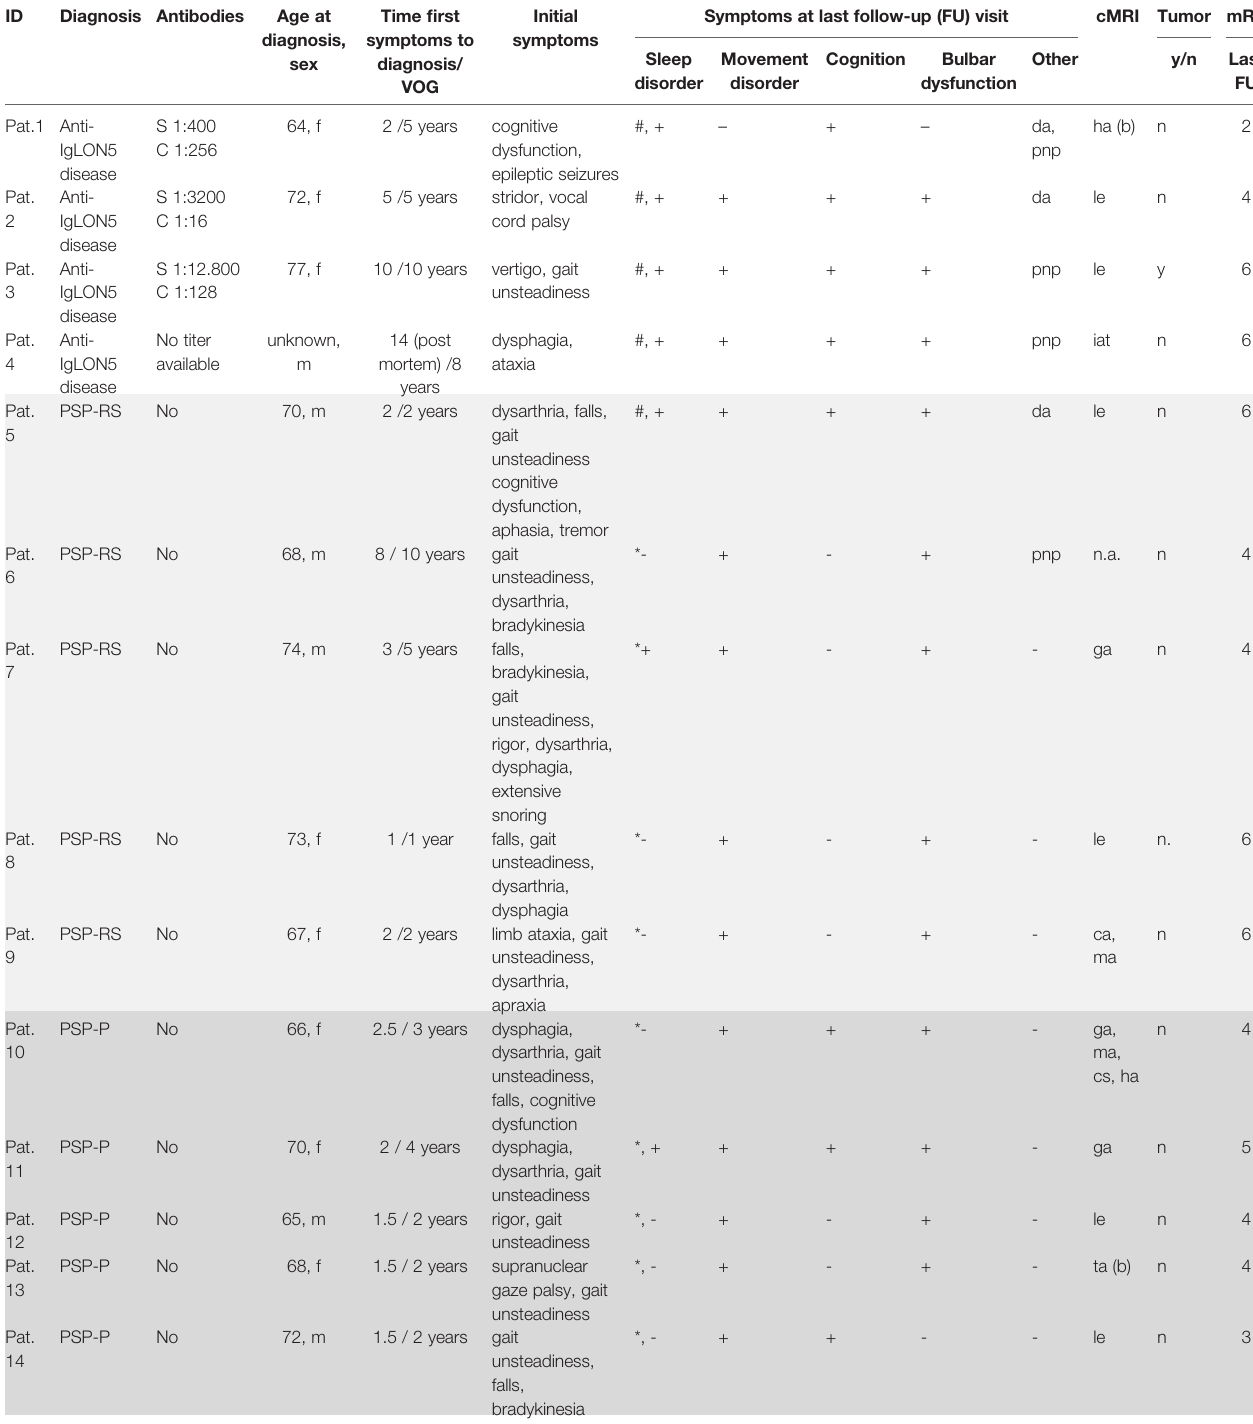
TABLE 1 | Baseline characteristics at time of diagnosis and symptoms at last follow-up